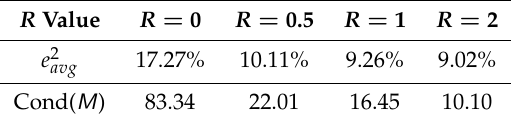
Table 2. e 2 avg and condition number of M (Cond( M )) for different exclusion disk size R